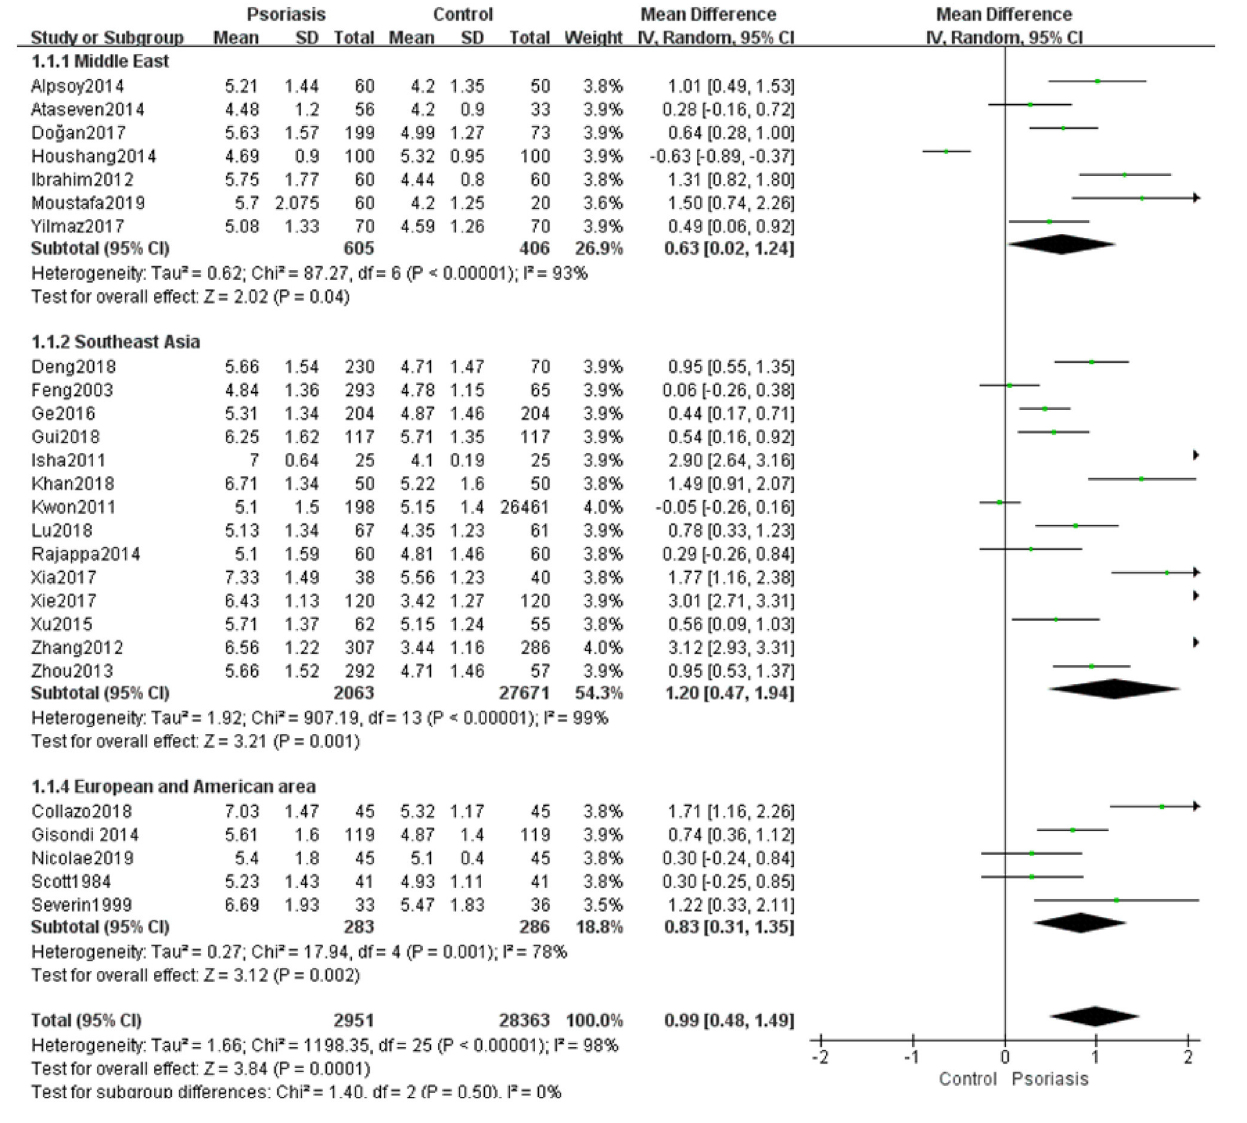
model ( I 2 = 40%, P = 0.17). There was heterogeneity in arthritic psoriasis subgroup ( I 2 = 69%, P = 0.07), little heterogeneity in the subgroup of erythrodermic psoriasis ( I 2 = 0%, P = 0.35),